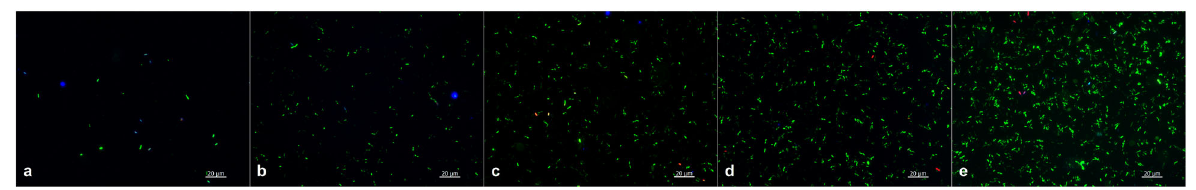
were rinsed after incubation and between staining steps to select only adhering microorganism. Staining of the bio fi lm was done with